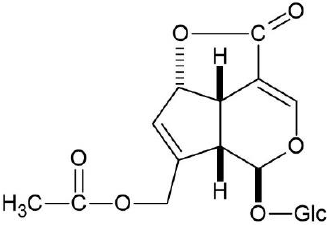
Figure 6. Chemical structure of asperuloside.